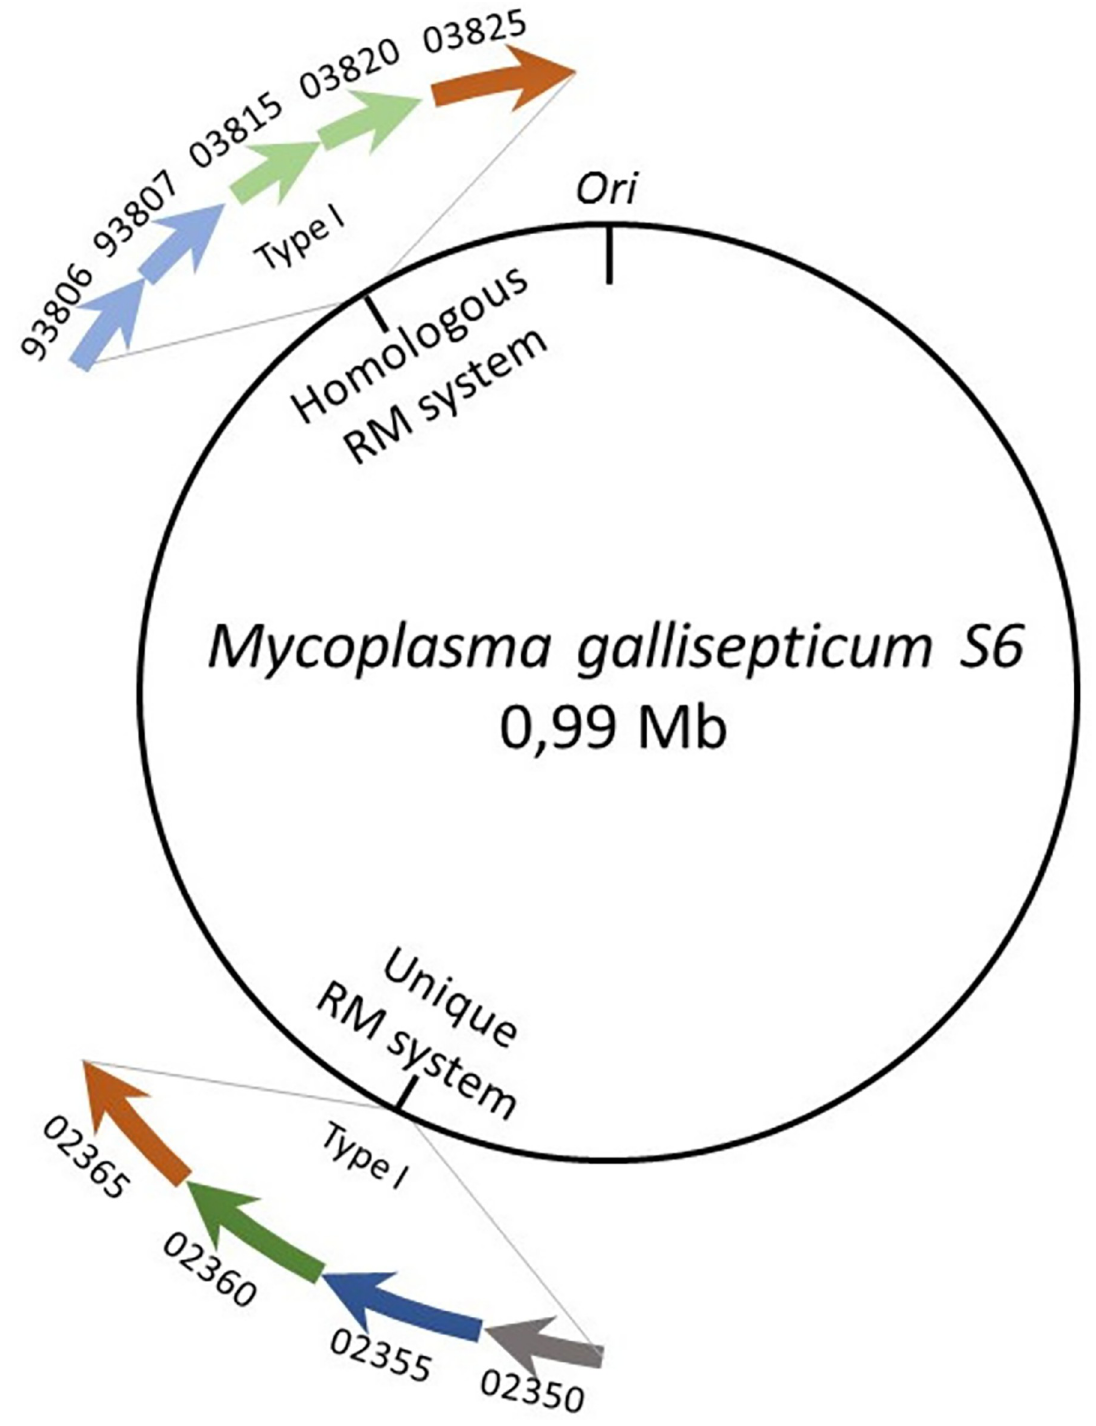
Fig 3. Restriction-modification systems of M . gallisepticum S6. Arrows represent the ORFs; grey, blue, green, and orange colors indicate genes hsdC (controller protein), hsdM (methyltransferase), hsdS (specificity subunit), and hsdR (restriction subunit), respectively. Ori–origin of replication. Faded colors represent disrupted